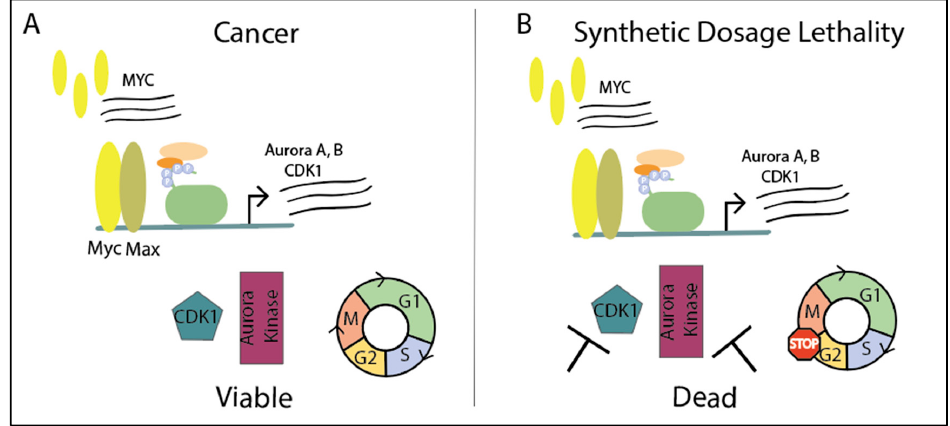
Targeting Cell Cycle